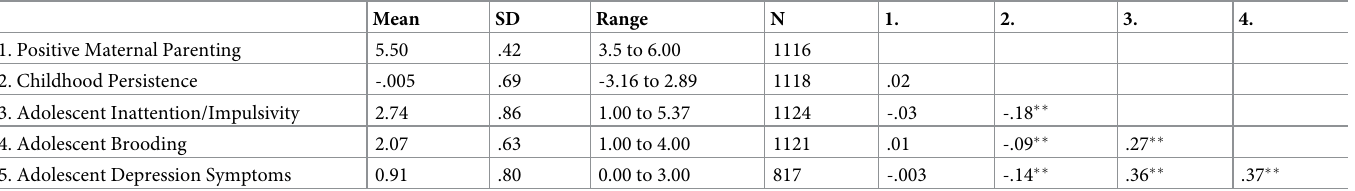
Table 1. Means, standard deviations, and bivariate correlations among indicator variables included in latent profile analysis. Mean SD